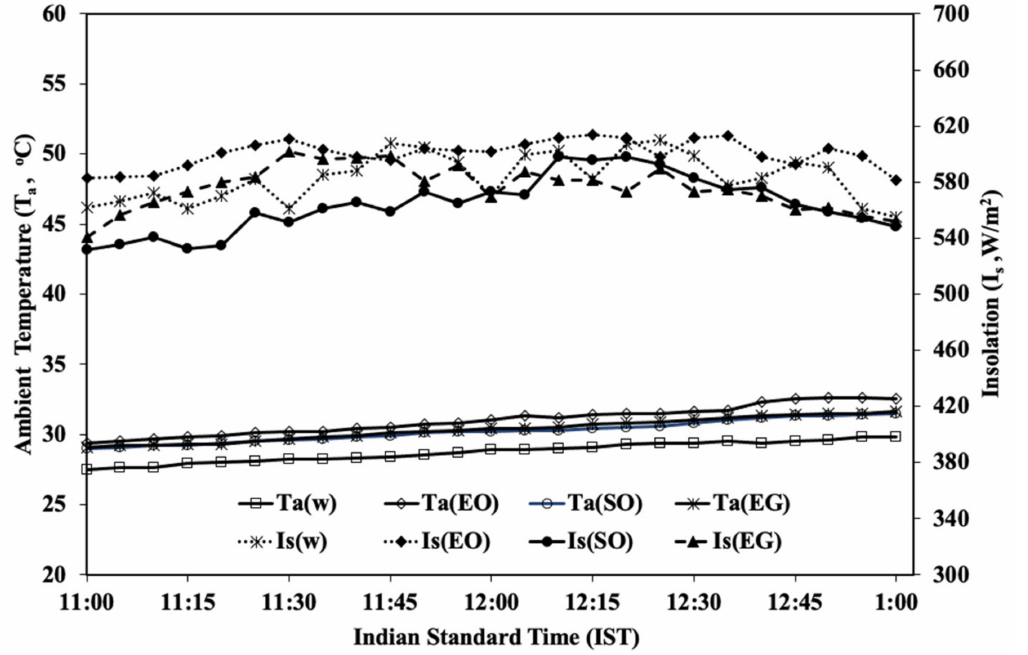
Figure 5. Variation of solar insolation ( I s ) and ambient temperature ( T a ) with Indian standard time (IST) on experimental days, EO 15 November, EG 17 November, SO 20 November and Water 23 November 2021.